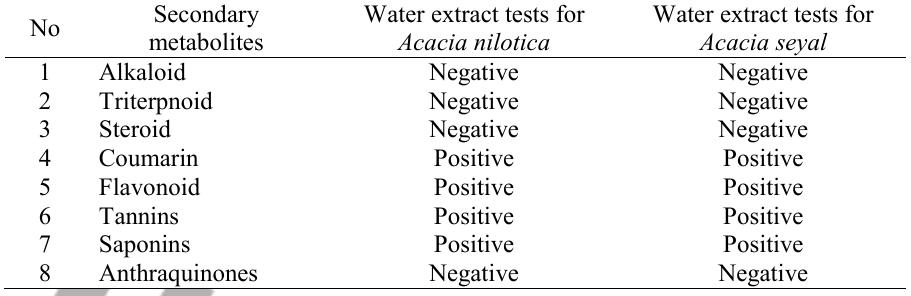
Table 2 . Acacia nilotica and Acacia seyal phytochemical screening